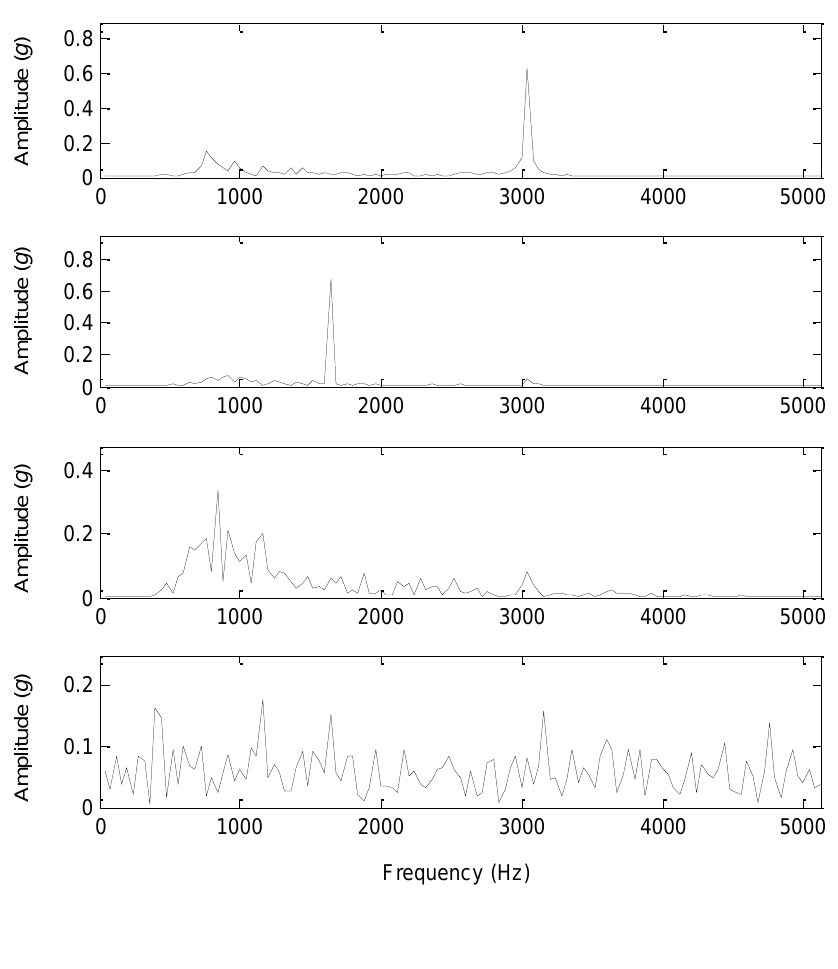
Figure 16. The spectra of the separated